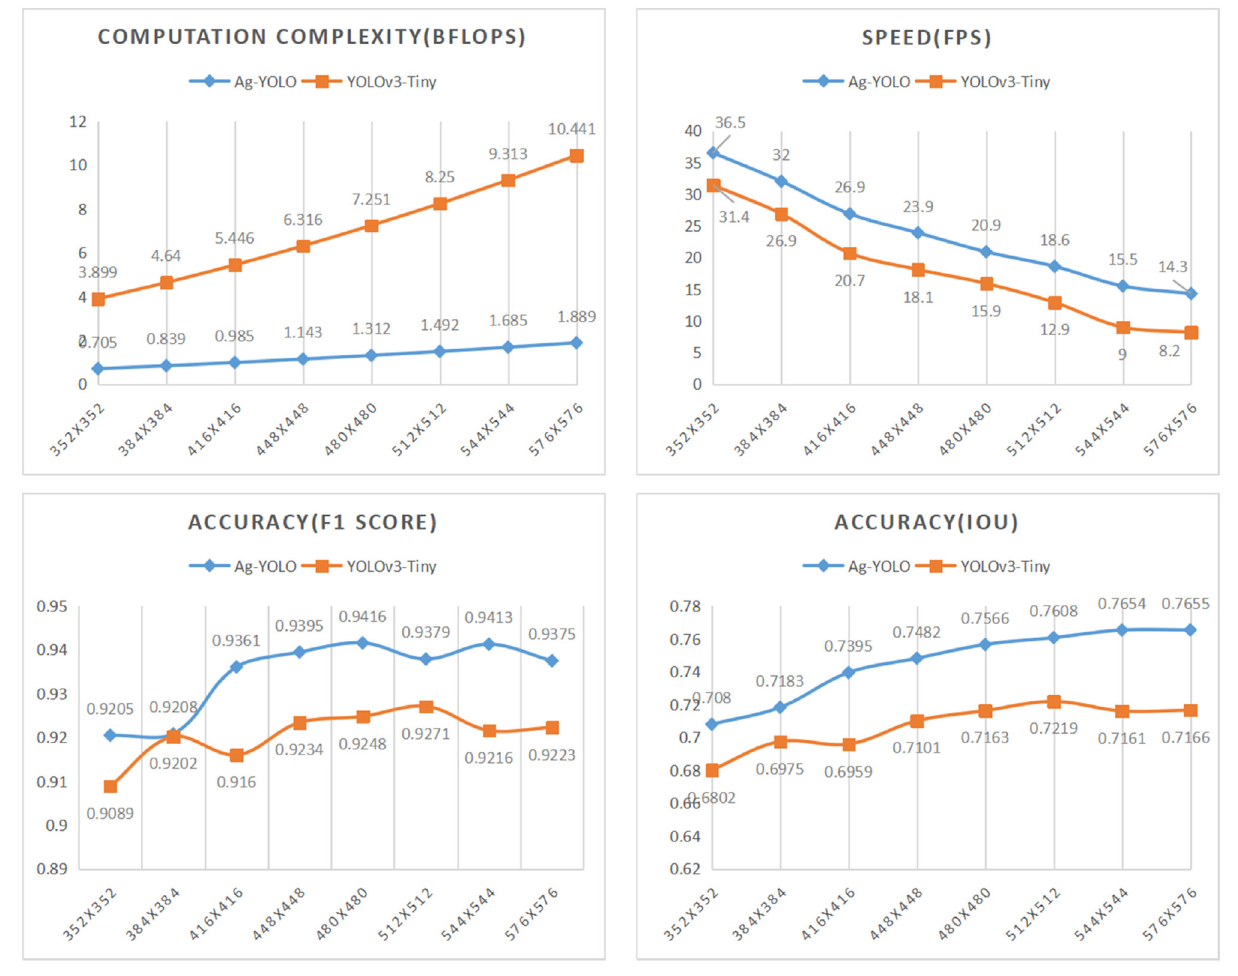
When the input dimension was set to 352 × 352, Ag-YOLO achieved the speed of 36.5 fps with an F1 score of 0.9205 and IoU of 0.708 on NCS2, while YOLOv3-Tiny achieved